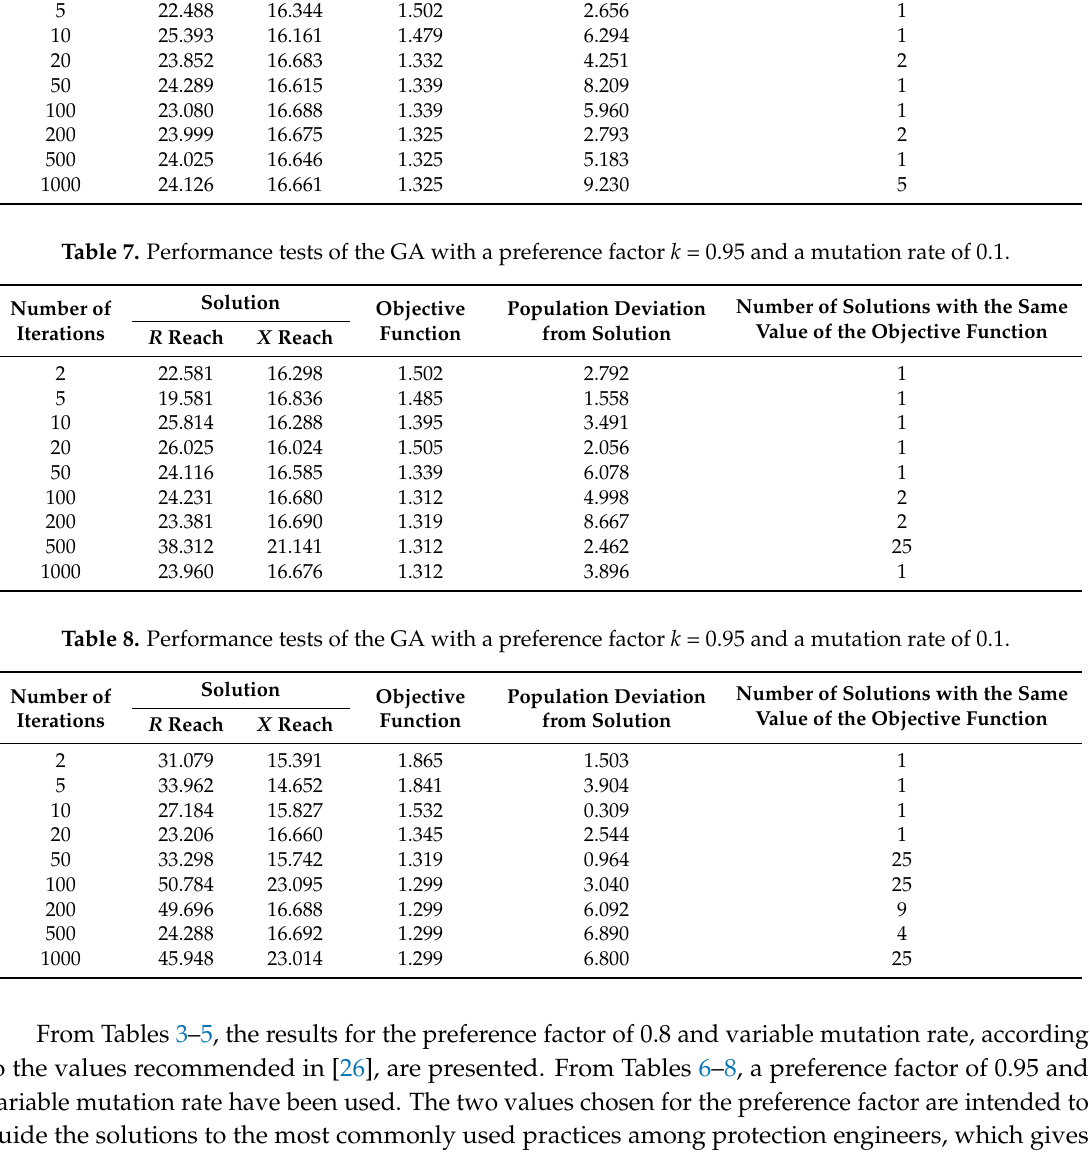
Table 6. Performance tests of the GA with a preference factor k = 0.95 and a mutation rate of 0.2. Solution Objective Number of Iterations Function